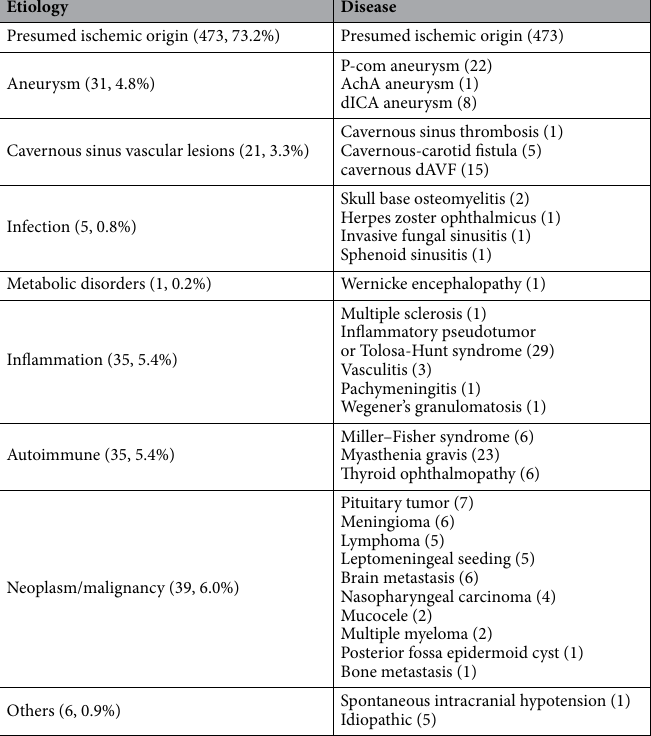
Table 2. Causes of ocular cranial nerve palsy (OCNP). P-com posterior communicating artery, AchA anterior choroidal artery, dICA distal internal carotid artery, dAVF dural arteriovenous